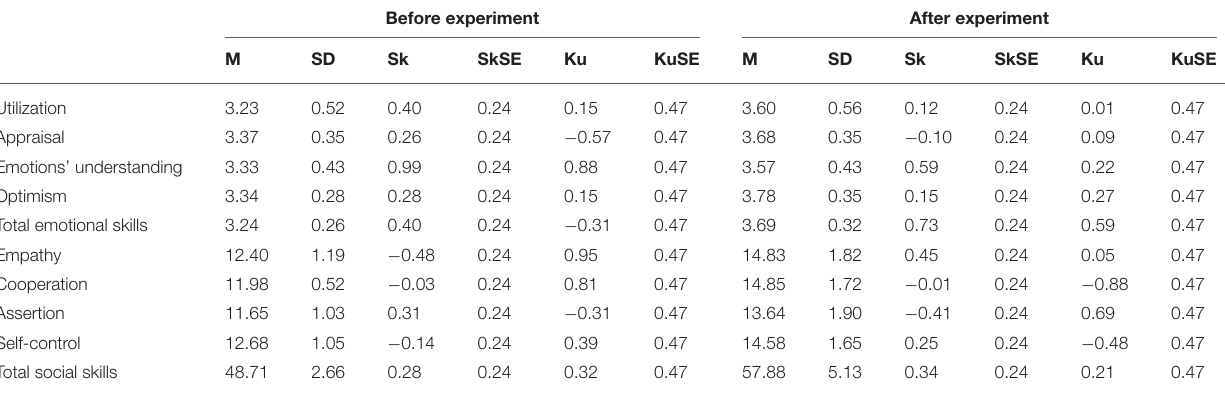
TABLE 2 | Means (M), SD, and normality tests of the study variables ( N = 104).